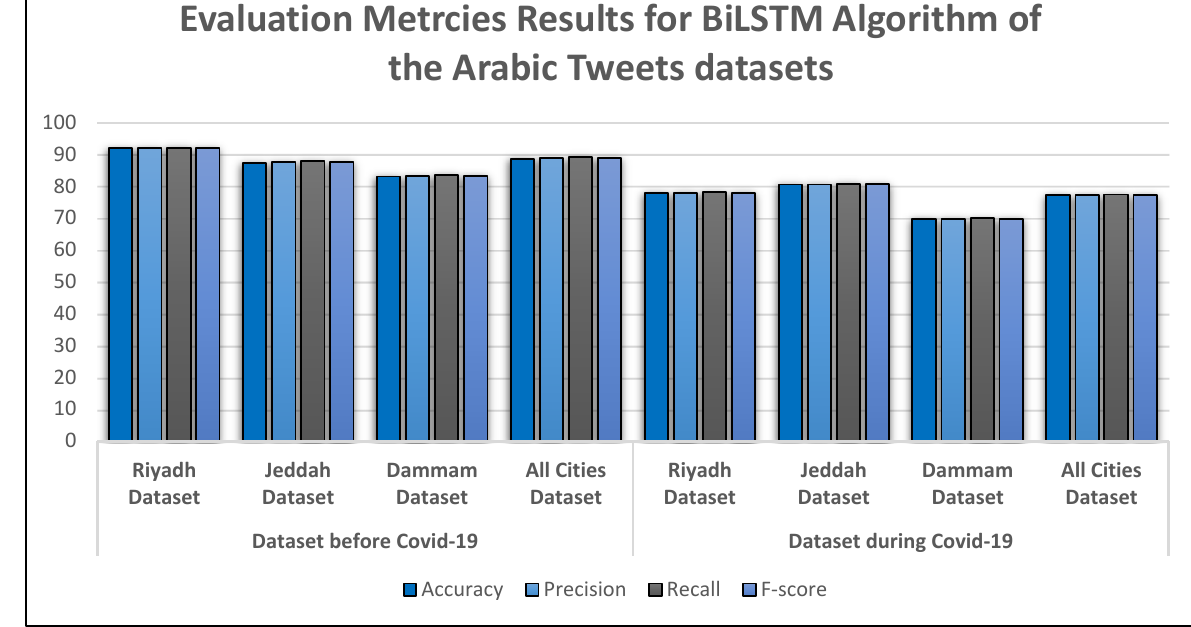
Figure 12 . The Chart of Results of the BiLSTM algorithm for all datasets. Figure 12. The Chart of Results of the BiLSTM algorithm for all datasets. Table 9. The performance metrics of CNN and BiLSTM algorithms on datasets in all two